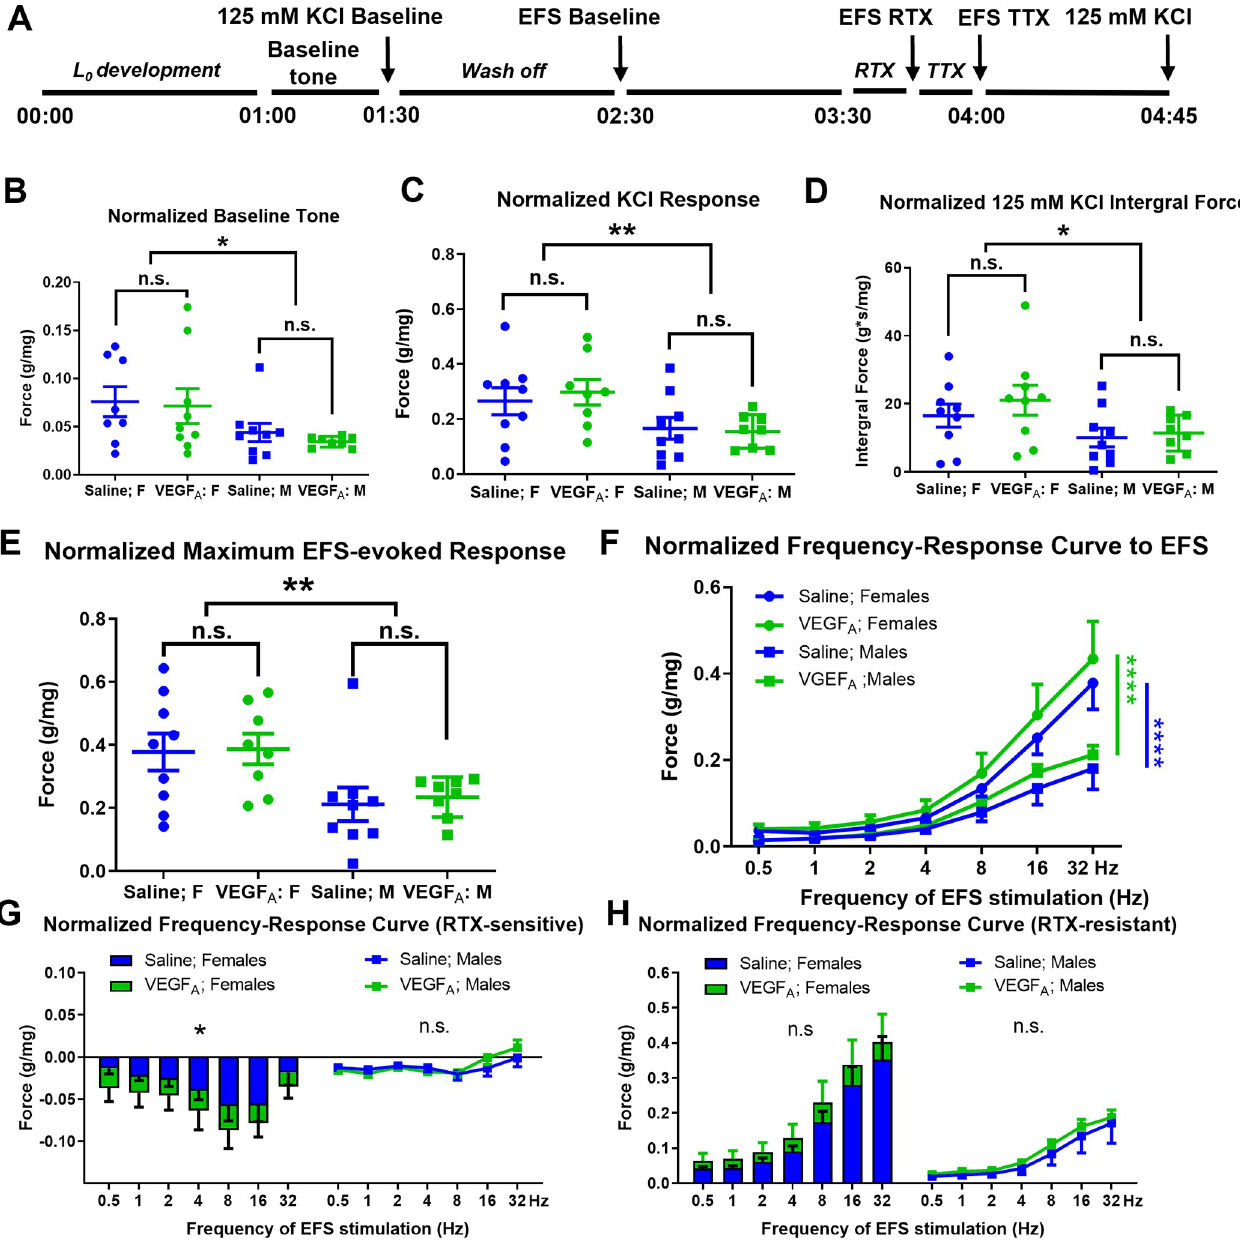
Fig 3. Intravesical instillation of VEGF A did not affect intrinsic detrusor contractility but enhanced RTX-sensitive, nerve-mediated detrusor strip contractility in female mice. (A). Experimental timeline of BSMCS studies. L 0 was established during the first hour of each experiment. Bladder strips were subsequently exposed to 125mM KCl, RTX, TTX, and EFSs. (B). Basal force recorded before the first KCl application. Female mice displayed higher baseline force than male mice. (C-D). Bladder muscle contractility force induced by 125 mM KCl application. (C). Female mice exhibited higher KCl-induced bladder muscle contraction than male mice. (D). The integral force of bladder muscle KCl responses. Female mice exhibited higher integral force of KCl-induced bladder muscle contractions than male mice. (E-H). Nerve-stimulation induced muscle responses. (E). Female mice showed higher maximum bladder muscle contraction induced by EFS than male mice. (F). Sex differences were also detected in the EFS-induced frequency-response curves. (G). Bladder strips isolated from VEGF A -instilled mice exhibited significantly greater RTX-sensitive bladder contractions when compared to those isolated from saline-instilled female animals. (H). No significant differences were detected in RTX resistant, nerve-evoked bladder contractions between saline- and VEGF A -instilled mice in either